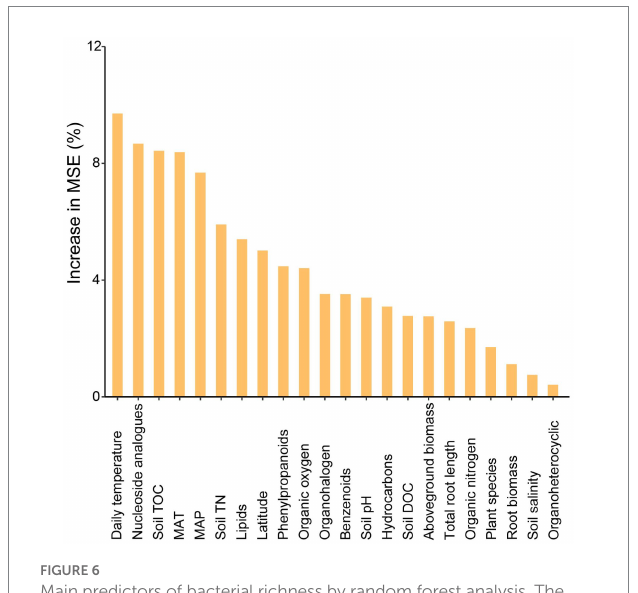
FIGURE 6 Main predictors of bacterial richness by random forest analysis. The figure shows the random forest results with the main predictor importance (% of increase of MSE) of environmental drivers on bacterial